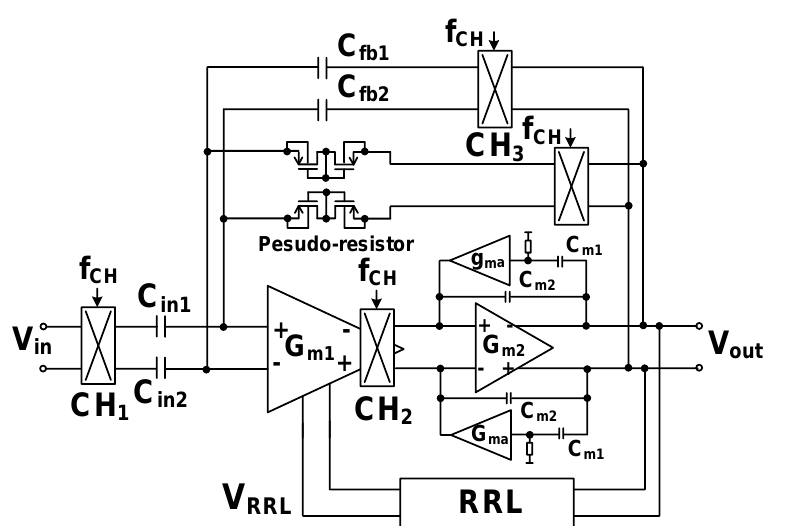
Figure 7. Schematic of the CCIA using active feedback frequency compensation (AFFC) and ripple- reduction loop (RRL). C in1,2 = 15 pF, C fb1,2 = 0.14 pF.